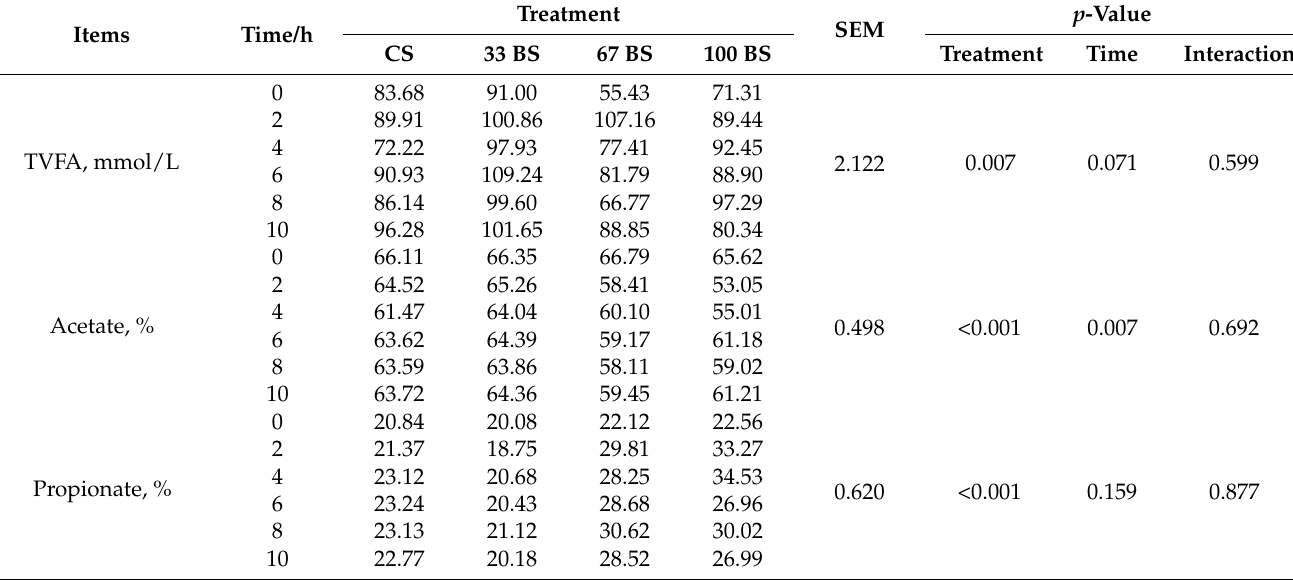
Table 3. Effects of different barley ratios in diets on volatile fatty acids in the rumen of Hu